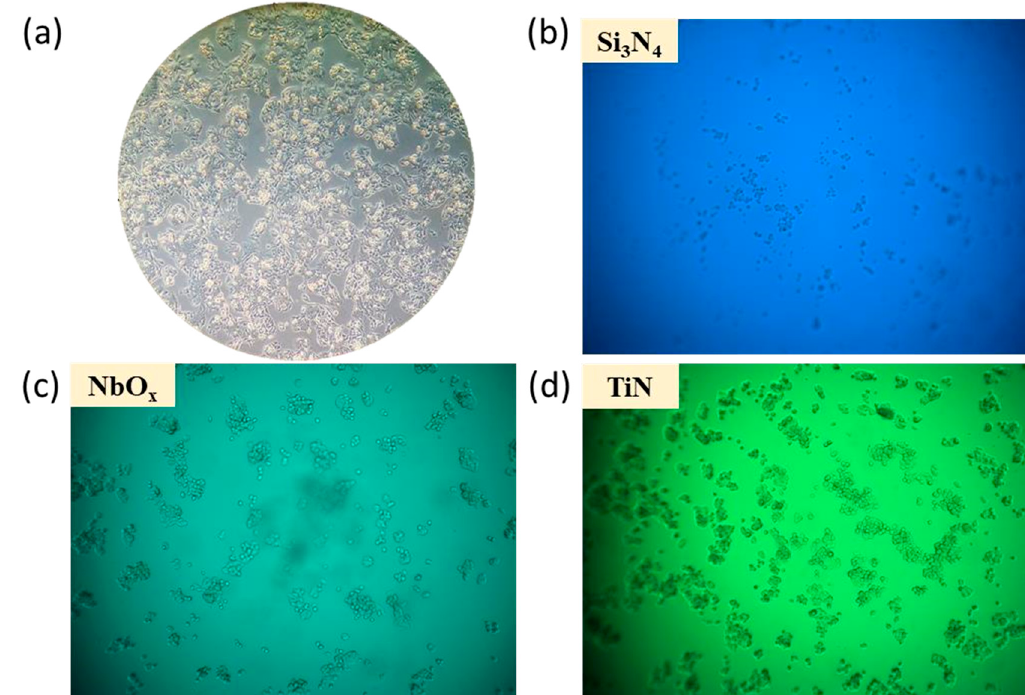
Figure 2. C3A cell images on ( a ) culture dish, ( b ) Si 3 N 4 , ( c ) NbOx and ( d ) TiN/SiO 2 LAPS surface.